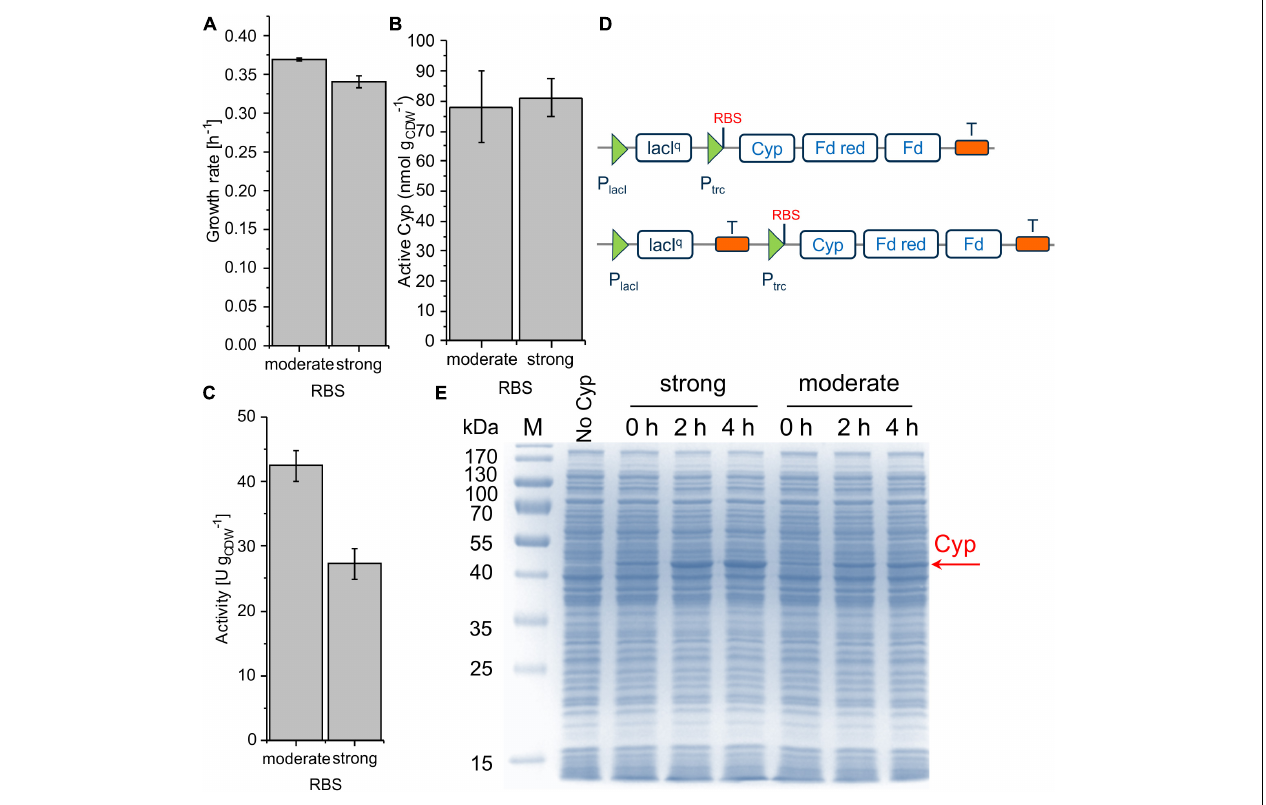
FIGURE 5 | Growth rate (A) , concentration of active Cyp determined via CO difference spectra (B) and specific cyclohexane hydroxylation activity (C) of P. taiwanensis VLB120 pSEVA244_T_RBS ∗ _Cyp (moderate RBS) and pSEVA244_T_BB34_Cyp (strong RBS) after 4 h of induction. For resting cell assays, cells were processed as described in the legend of Figure 3 . The bars represent average values. Panel D illustrates the molecular insertion of the double terminator. Standard deviations of two independent biological replicates are given. The average experimental errors over all measurements for the growth rate, active Cyp concentration, and activity are 1.4, 11.4, and 7.2%, respectively. SDS-PAGE analyses of each strain used for activity assays (E) show the corresponding Cyp content (at 47.4 kDa).